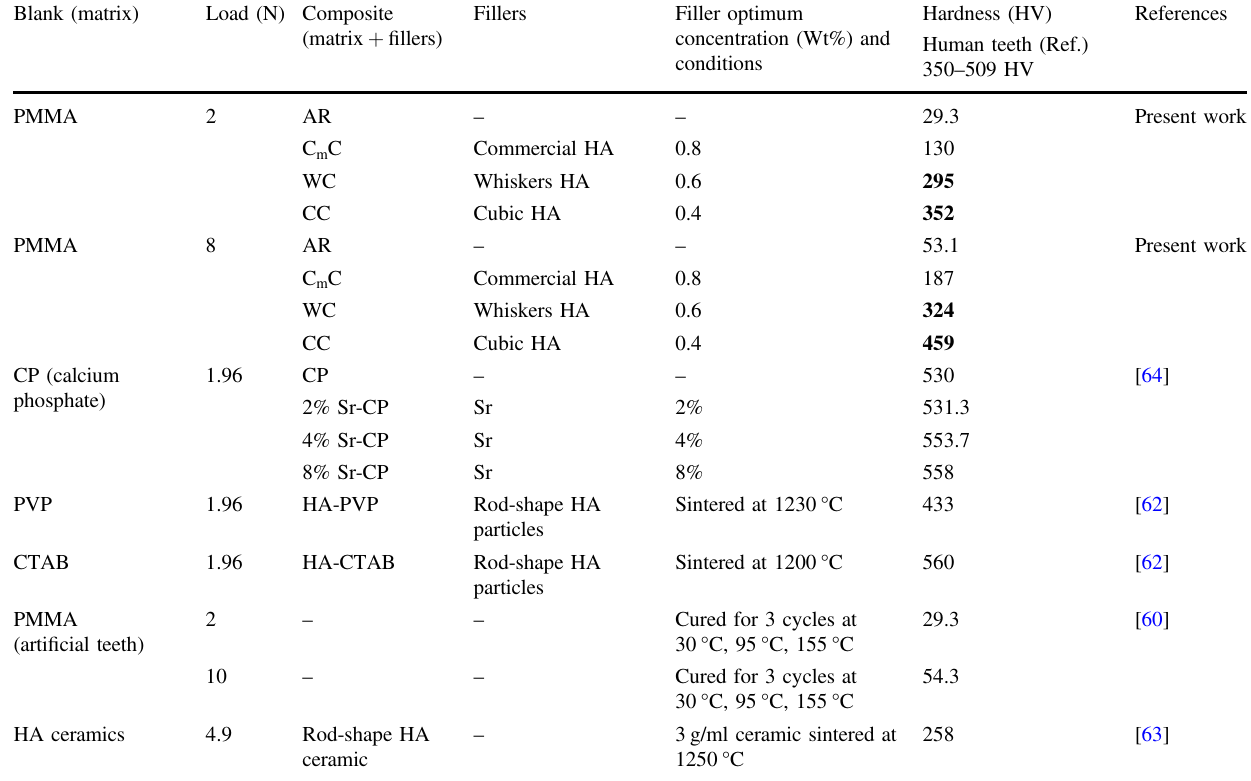
Table 8 Comparison of the hardness of the as-synthesized composites (AR, C m C, WC, and CC) with the literature Blank (matrix)